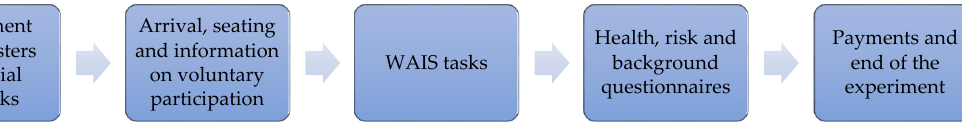
Figure 1. Experimental